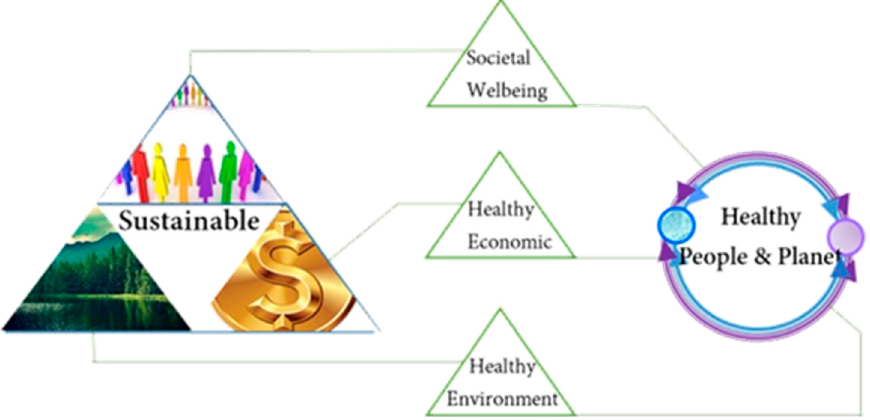
Figure 6. Schematic demonstration of three famous pillars of sustainability for WB [42].